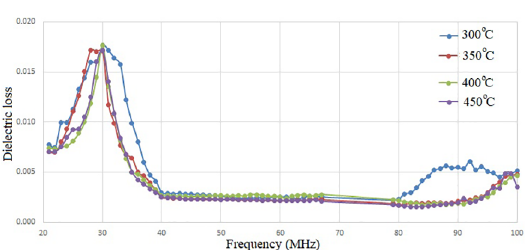
with different annealing 3